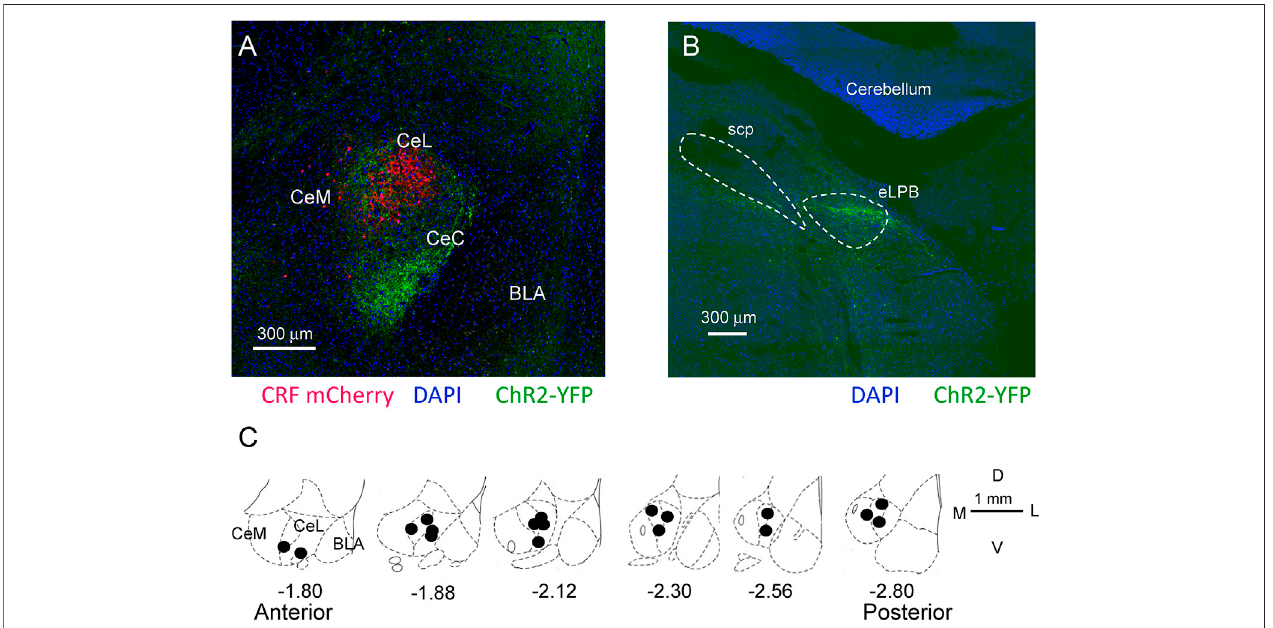
FIGURE2| LocationofCRFneurons,ChR2injectionsforoptogenetics,andmicrodialysisprobesintheCeA. (A) ConfocalimageofmCherrylabeledCRFneurons in a Crh-Cre rat 5 weeks post viral (AAV5- EF1 α -DIO-mCherry, red) injection into CeA. Glutamatergic terminals expressing channelrhodopsin 2 (ChR2-eYFP) 5 weeks post viral injection (rAAV5/CaMKIIa-ChR2(H134R)-eYFP, green) into the external parabrachial nucleus (PB). CeM, CeL, CeC, medial, lateral, and capsular divisions of amygdala; BLA, basolateral amygdala. (B) Injection site for rAAV5-CaMKIIa-hChR2eYFP in the external lateral PB for ChR2 expression in glutamatergic neurons. SPC, superior cerebellar peduncle. (C) Diagrams show coronal brain slices at different anterior-posterior levels. Filled circles indicate the positions of the microdialysis probe tips for drug application into CeA that were included in this